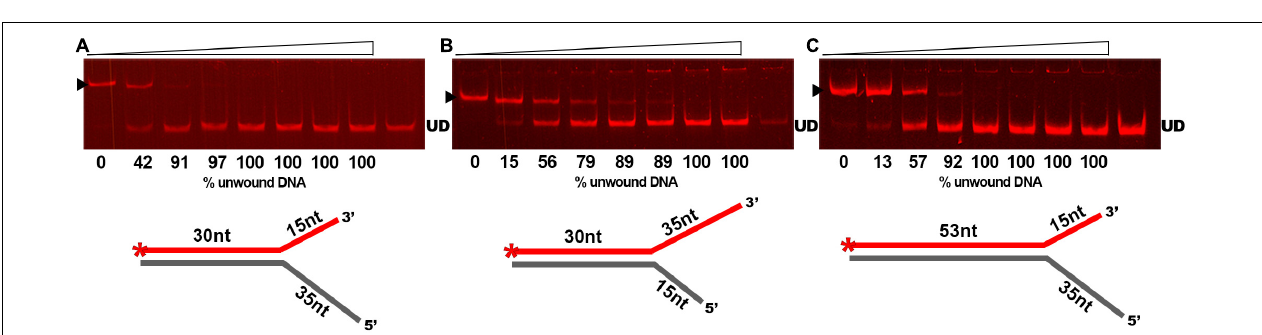
FIGURE 4 | Substrate-specific unwinding by GP46 F 13 . Reactions with asymmetric DNA substrate (A) 30duplex_5’ss or (B) 30duplex_3’ss. Rising concentrations of the GP46 F 13 protein (0, 0.1, 0.25, 0.5, 0.75, 1.0, 1.5, 2.0 µ M) was incubated with DNA substrate (1.5 nM) for 30 min at 30 ◦ C in reaction buffer (50 mM Tris-HCl, pH 8, 50 mM NaCl, 5 mM MgCl 2 ) and 5 mM ATP. Reaction samples were analyzed on native 15% polyacrylamide gels. (cid:73) indicates the expected migration of the substrate; UD indicates the expected migration of the unwound DNA (Cy5-labeled oligonucleotide) marked on the scheme in red and with an asterisk.